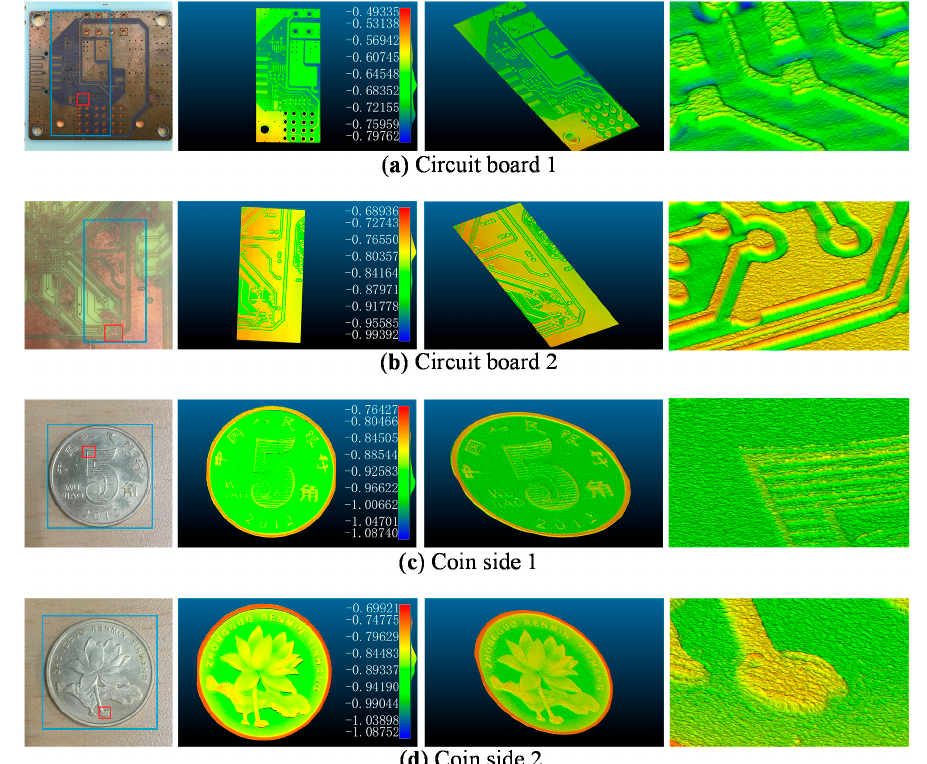
Figure 12. Measured results for some other samples. From left to right, every result presents the practicality picture, measured result in depth map (unit: mm), mesh result of surface reconstruction and partial detail for mesh result of the sample.